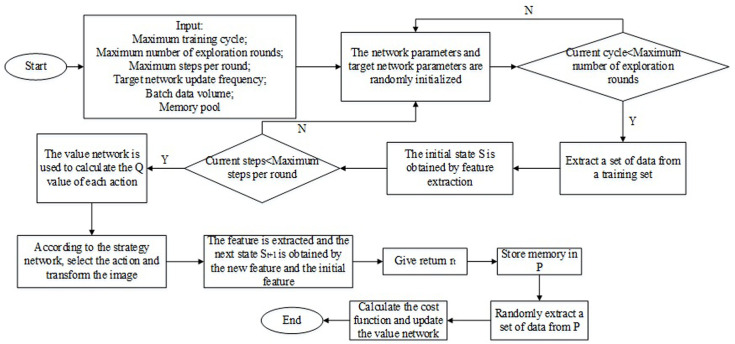
Overall implementation process of self-reinforcement network algorithm.